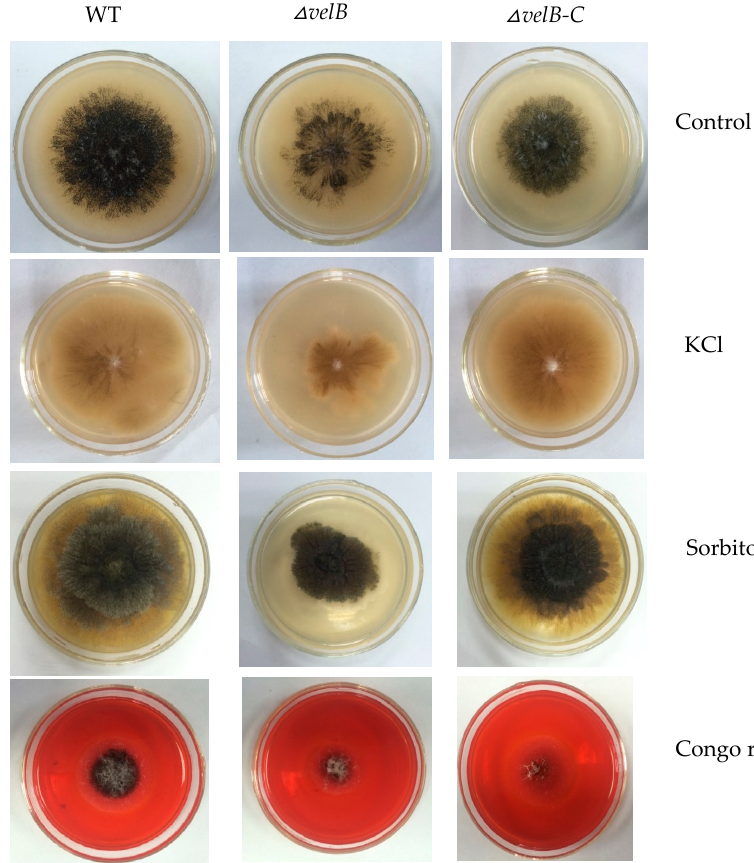
Figure 3. Sensitivity tests for NK17, △ velB , and △ velB -C strains. The strains incubated at 28 °C for five days on MM plates supplemented with 1 M KCl, 2 M sorbitol, or 0.04% Congo red. Each test was set in triplicate.